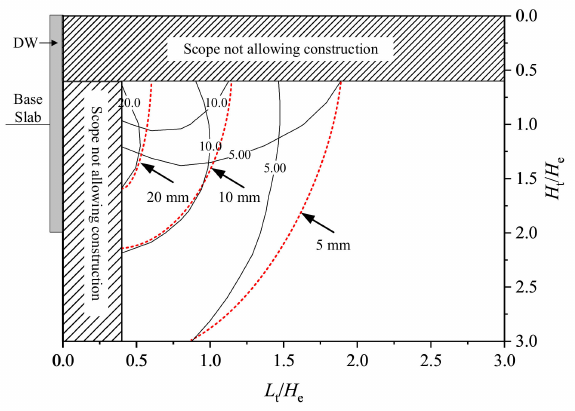
Figure 5. Influenced zones of deep excavation on adjacent tunnel displacement.